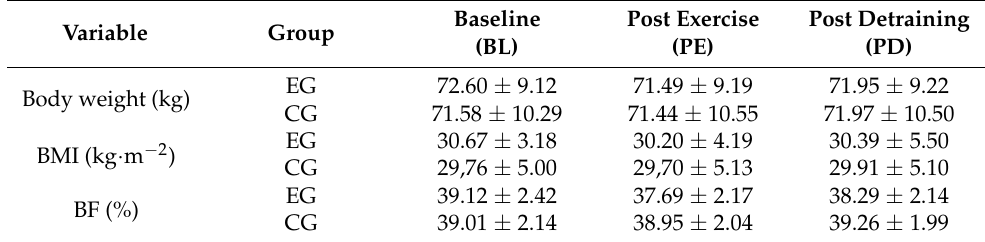
Table 1. Subject’s anthropometric